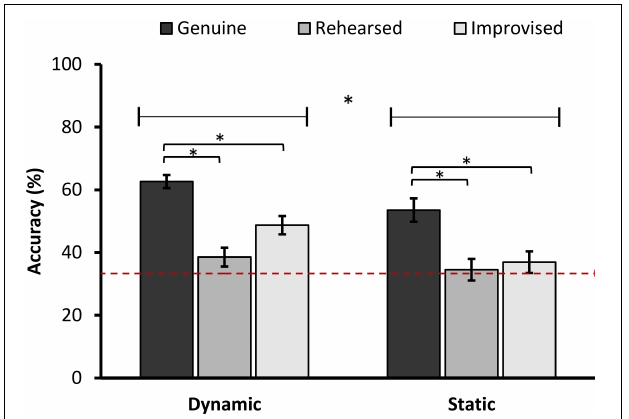
FIGURE 3 | Mean accuracies in authenticity discrimination in the dynamic and static format split by expression type (error bars ± 1 SE). The lines above the bars represents a main effect of Format. The brackets above the bars represent a significant difference between Expression type. The asterisks represent a significant difference at p < 0.001. The dotted line represents chance performance (33.3%).